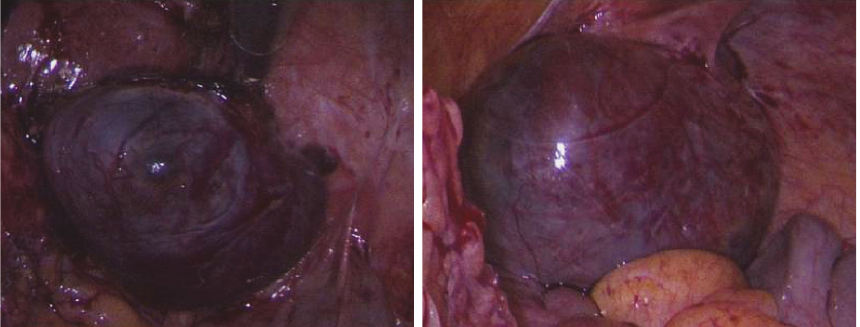
Figure 2: Intraoperative laparoscopic images of heterotopic pregnancy showing right tubal heterotopic